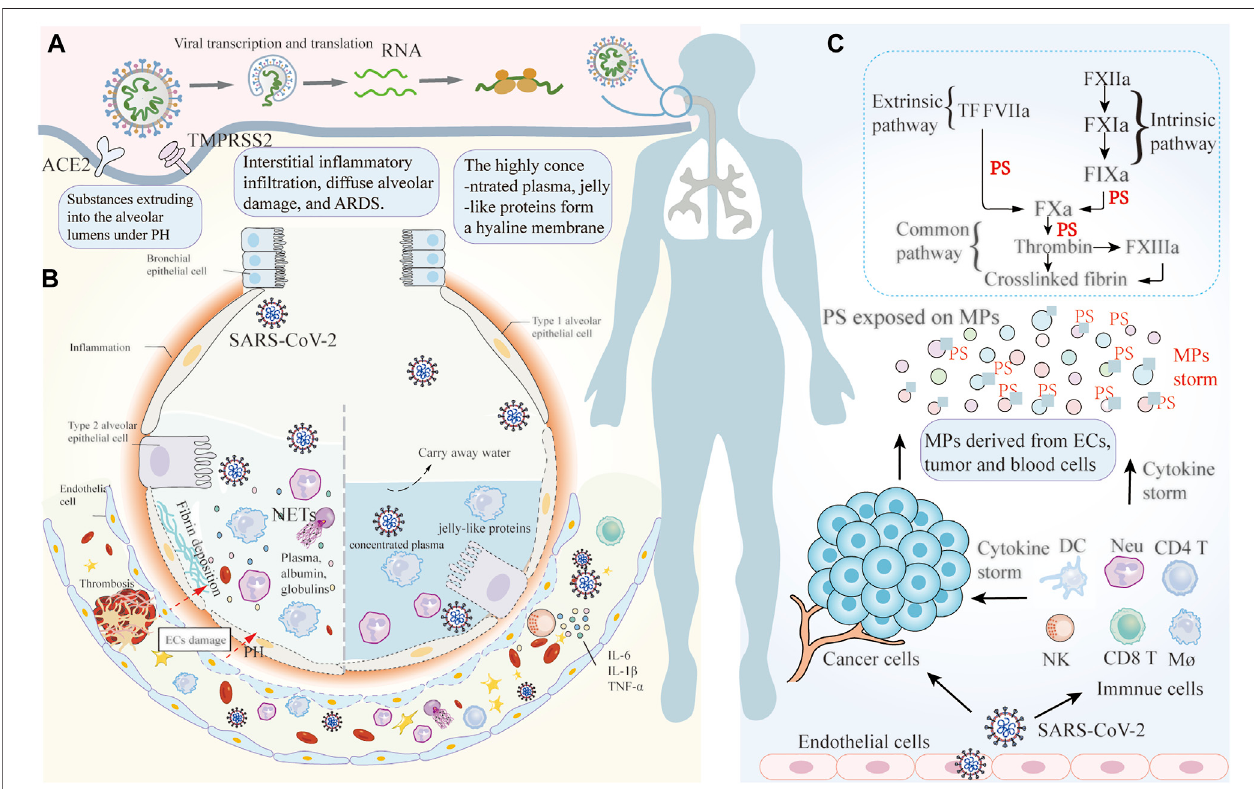
FIGURE 1 | The pathophysiological mechanisms of pulmonary coagulation in COVID-19 patients with cancer. (A) SARS-CoV-2 infects the epithelial cells of the upper respiratory tract and the conducting airways via ACE2 and TMRPSS2 receptors. The virus enters into the host cell and is then freed from the capsid for transcription and translation. (B) Illustration of the mechanisms of thrombi formation in COVID-19 patients with cancer, combining a cancer-induced hypercoagulable state and procoagulant factors of COVID-19. Extensive microthrombi induce elevated pulmonary capillary pressure, eventually leading to PH. Virus infection promotes the damage to alveolar epithelial cells and ECs, causing substances within the blood vessel to extrude into alveolar lumens under the conditions of PH, which impedesthegas-exchange.NETsandactivatedimmunecellsextruding intothealveolarlumensarecollectivelyresponsibleforinterstitialin fl ammatoryin fi ltration,diffuse alveolar damage, and ARDS. Mechanical ventilation can exacerbate the problem by drying the alveolar. The highly concentrated plasma and jelly-like proteins form a hyaline membrane in the alveolar space, and leading to ventilation-perfusion mismatch and serious hypoxia. (C) Massive activation of immune cells produces sustained in fl ammatory cytokines, which ultimately leads to cytokine storm. Cytokine storm further induces PS-positive MPs to be released from various cells, includingblood and cancercells,ultimatelyresultinginsystemicthrombosisinsidethevascular.ACE2:angiotensin-convertingenzyme2;TMPRSS2:typeIItransmembraneserineprotease; PH:pulmonaryhypertension;ECs:endothelialcells;ARDS:acuterespiratorydistresssyndrome;RBCs:redbloodcells;PLTs:platelets;Neu:neutrophil;NKcells:natural killercells;DCs:dendriticCells;Mø:macrophages;IL:interleukin;TNFTumornecrosisfactor- α :Tumornecrosisfactor- α ;IFN- γ ;Interferon- γ ;MPs:Microparticles;NETs: neutrophil extracellular